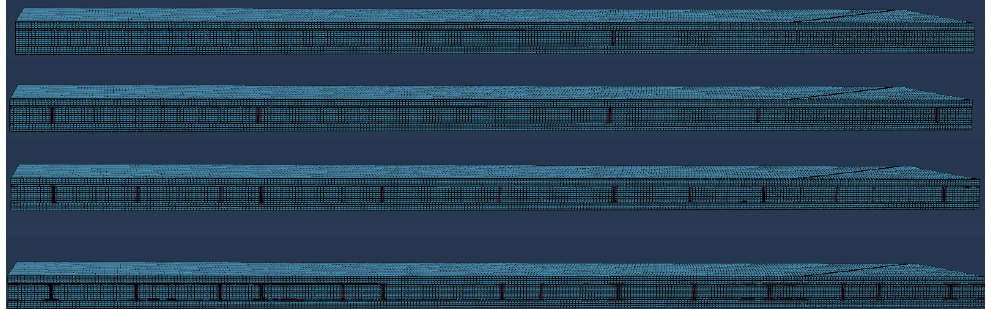
Figure 6. Middle layer transverse cracks at different time steps.